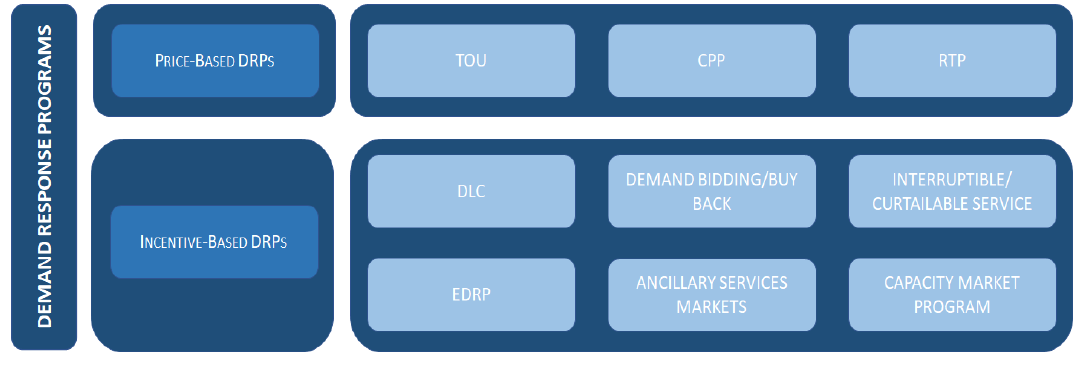
Figure 2. Illustration of several DRPs.